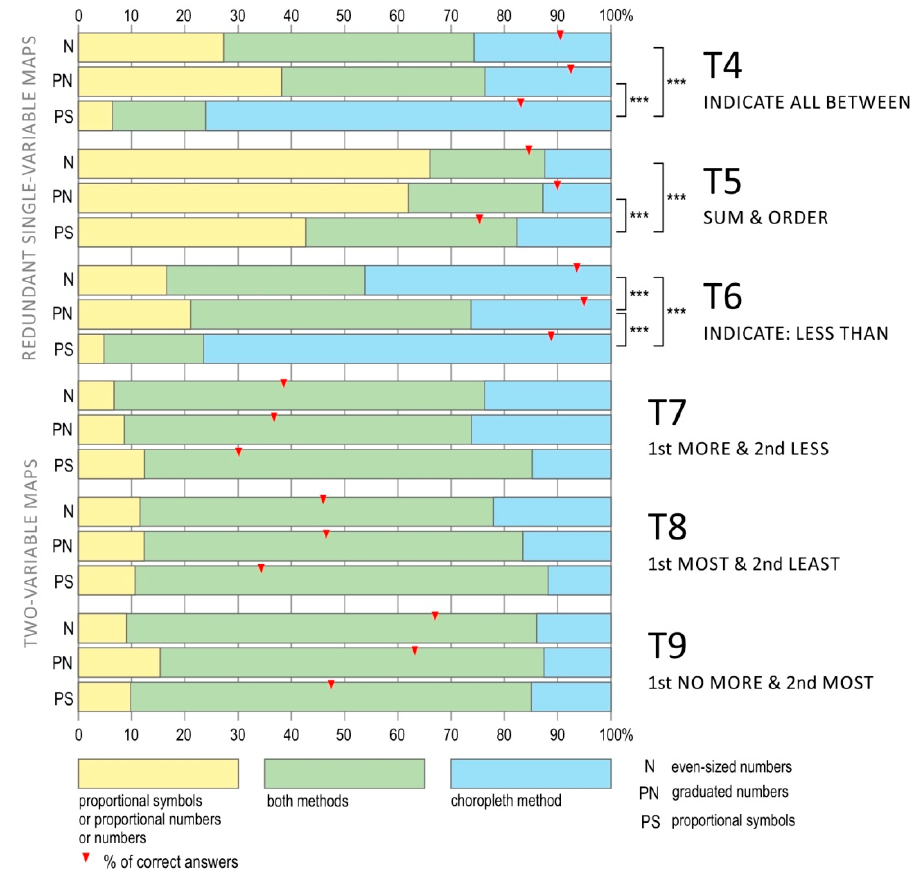
Figure 7. Comparison of the methods declared to be the most helpful in answering the individual tasks.